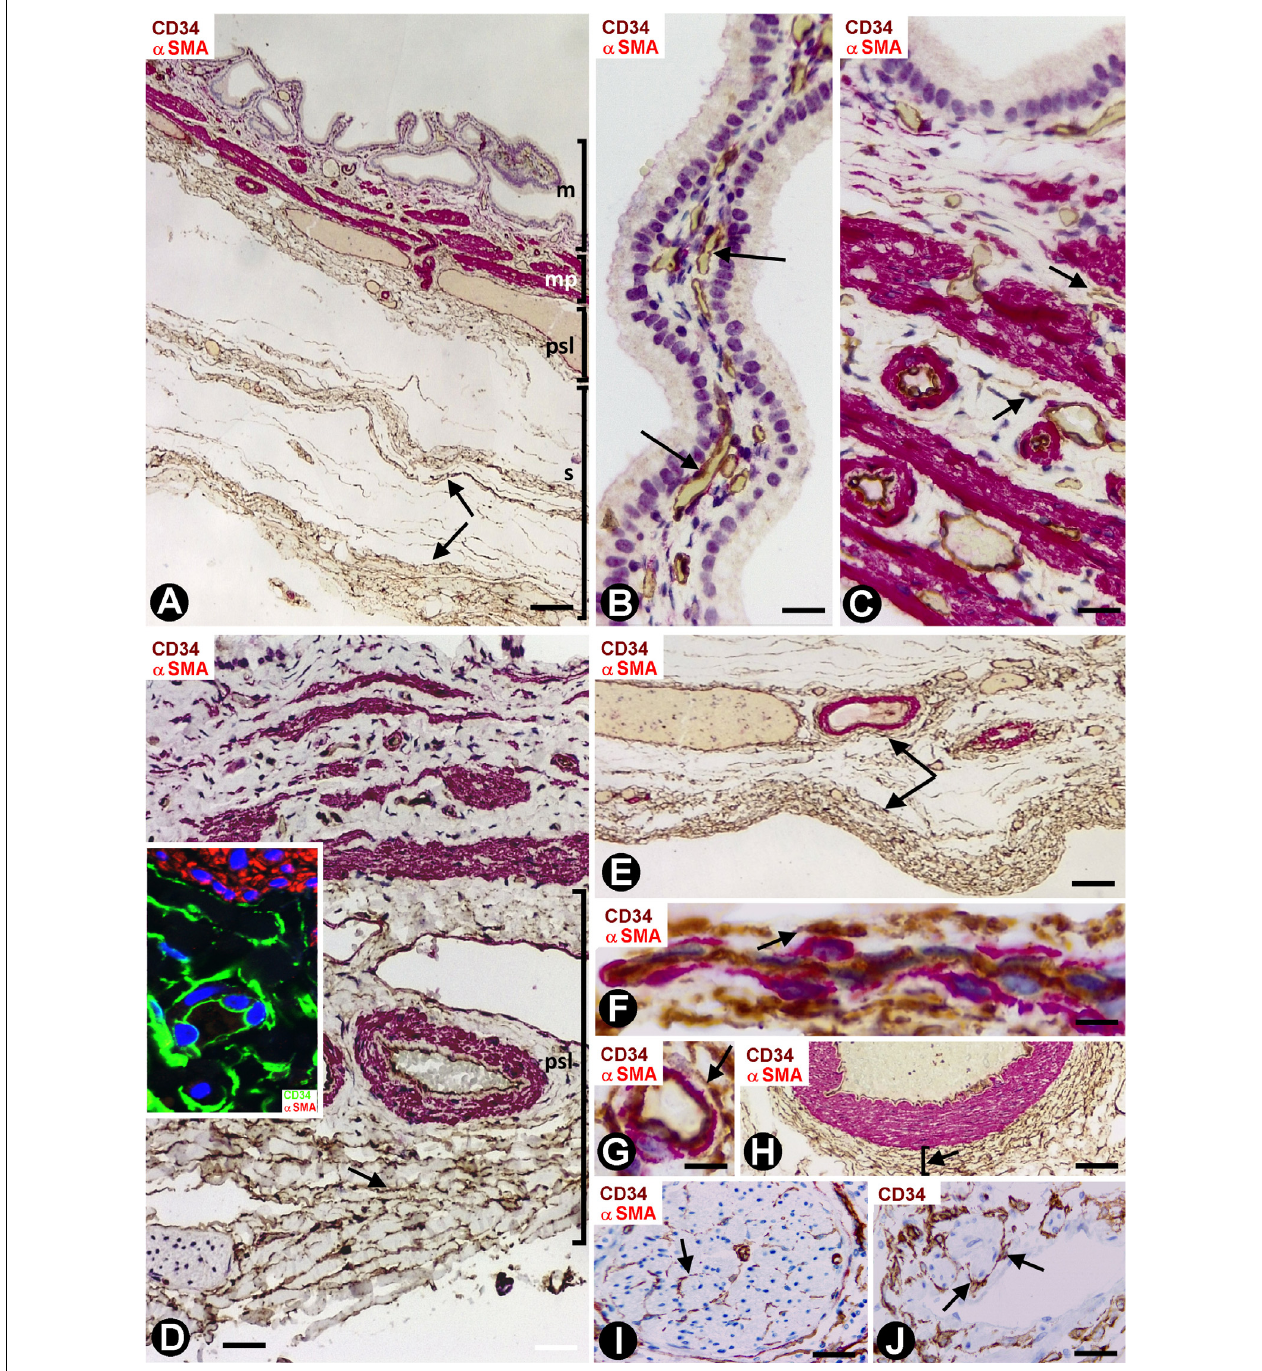
FIGURE 1 | CD34+ SCFTs in the normal gallbladder. (A–I) Sections double-stained with anti-CD34 (brown) and anti- α SMA (red). (J) Section stained with anti-CD34 (brown). (A) Panoramic view of gallbladder wall layers, mucosa (m), muscularis propria (mp) (smooth muscle cells: red), perimuscular subserosal layer (psl) and serosa (s), in which a different distribution of CD34+SCs/TCs (brown) is observed, predominantly in the perimuscular subserosal layer and in strands in the serosa (arrows), parallel to the serosa surface. (B) Absence of CD34+SCs/TCs in the corium of the mucosa; the endothelial cells are the only cells stained with anti-CD34 (arrows). Note that CD34+SCs/TCs are also absent in the perivascular spaces, which may or may not contain pericytes. (C,D) CD34+SCs/TCs (arrows) in the muscularis propria. In panel (D) , observe numerous CD34+SCs/TCs (brown, arrow) in the perimuscular subserosa layer (psl). In the insert, smooth muscle cells ( α SMA+, red) and CD34+SCs/TCs (green). (E) Abundant CD34+SCs/TCs (brown, arrows) in parallel strands in the serosa. (F–J) Details of the location of CD34+SCs/TCs in vessels, nerves, and lymphatics (arrows). Note CD34+SCs/TCs around pericytes in the pericytic microvasculature ( F,G , arrows), in the adventitia of an artery ( H , arrow), in a nerve ( I , arrow) and in a lymphatic pre-collector ( J , arrow). Bar: (A) 160 µ m; (B) 20 µ m; (C,H–I) 40 µ m; (D) 60 µ m; (E) 80 µ m; (F,G) 10 µ m.